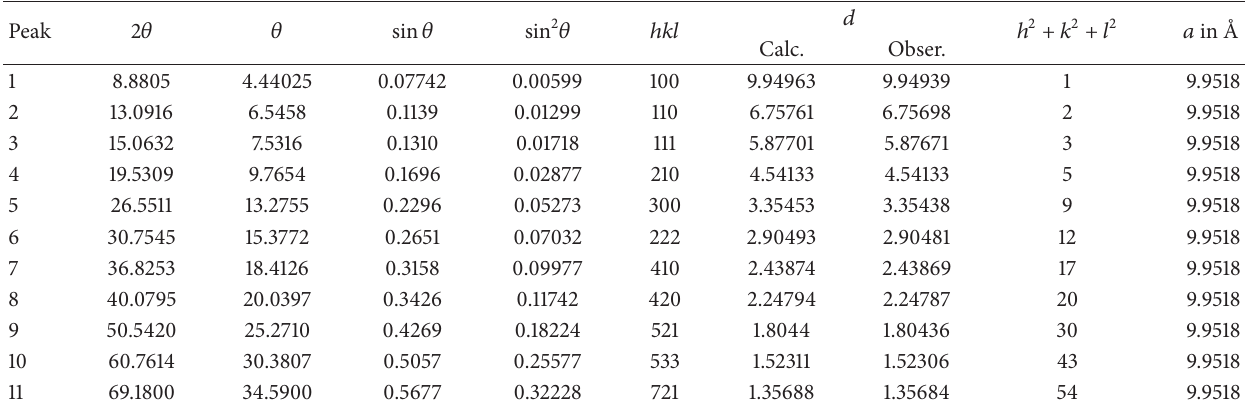
Figure 10: Proposed structure of the complexes of ligand HL. Table 7: Powder X-ray diffraction data of Co(II) complex of the ligand